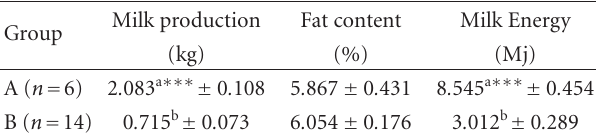
Table 1: Average milk yield (kg), milk fat content (%) and net milk energy (Mj) of experimental ewes.